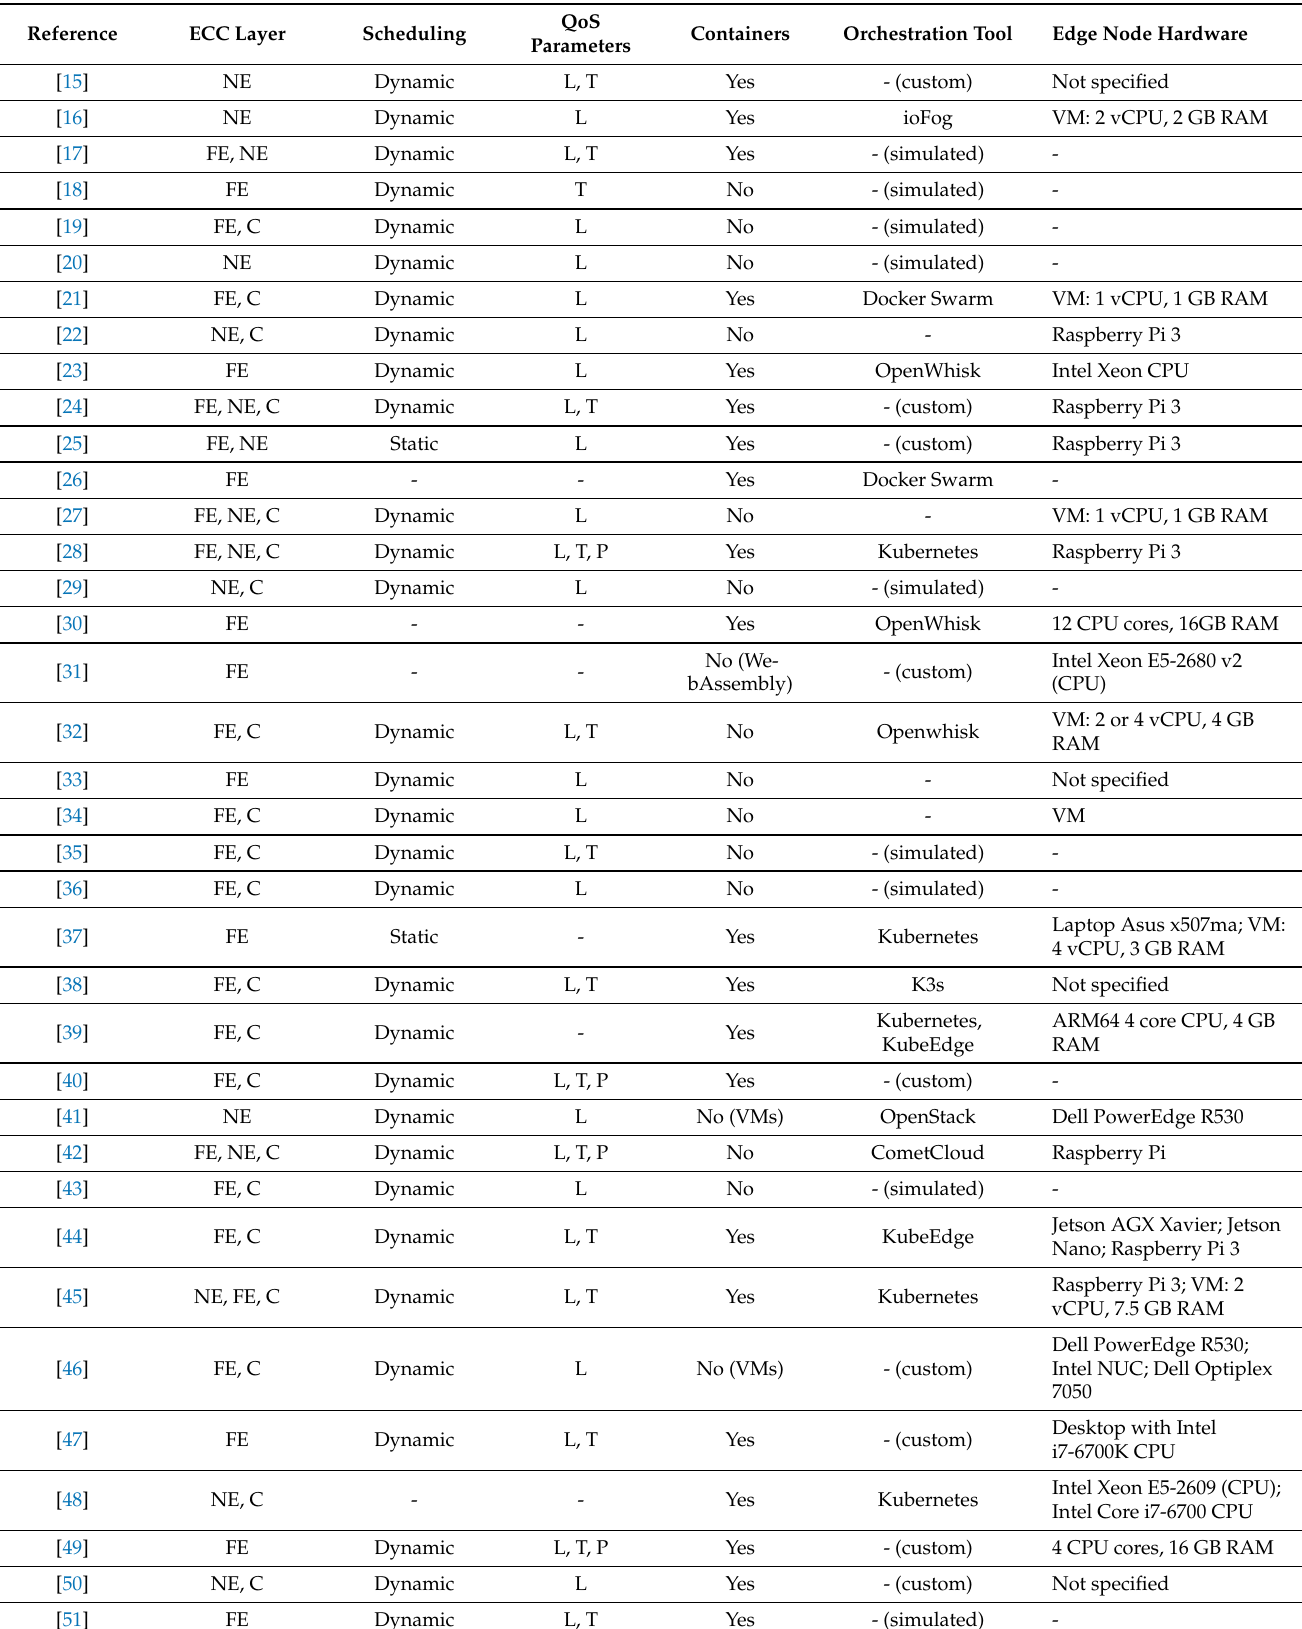
Table 2. Related work in the field of edge service